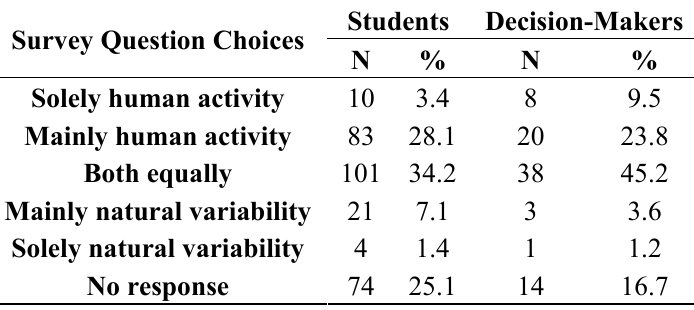
Table 5. Responses for “to what extent are human activity and natural climate variability responsible for climate change”.